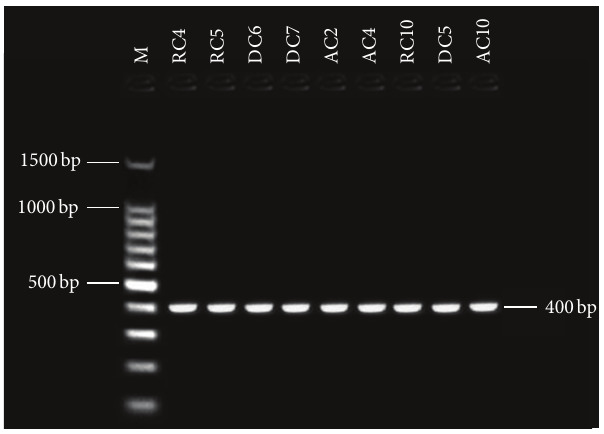
Figure 2: Gel electrophoresis analysis PCR products using nor-1 primer with 400bp, lanes from RC4 to AC4 ( A. flavus ), lanes from RC10 to AC10 ( A. parasiticus ), and lane M: 100 bp DNA ladder size marker.